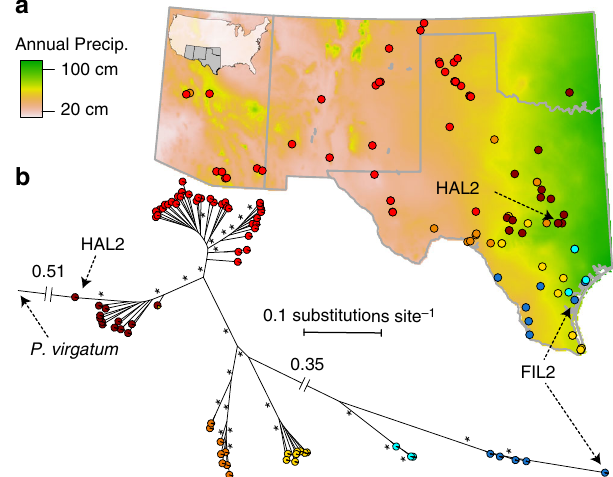
Fig. 1 Genetic structure and geographic distribution of P. hallii. One individual was deeply re-sequenced from 94 locations across southwest USA ( a ). Filled points represent the geographic location of the population where each individual was collected. Point colors represent genetic subpopulation assignments from STRUCTURE. The map background is cropped from the annual precipitation (BIO12) 2.5-minute raster (http:// worldclim.org/version2) via a 10-minute United States of American state- boundary vector shape fi le (http://naturalearthdata.com). In addition to between-variety divergence ( fi lipes : blue, hallii : red/orange/yellow), there was strong population structure within varieties ( b ); proportional subpopulation assignment is shown in pie charts at the branch tips. Branch lengths are proportional to the number of substitutions per variable site, except the root branch and the internal branch connecting varieties, which are labeled with the respective lengths; branches marked * have bootstrap support >90%. Source data are provided as a Source Data fi